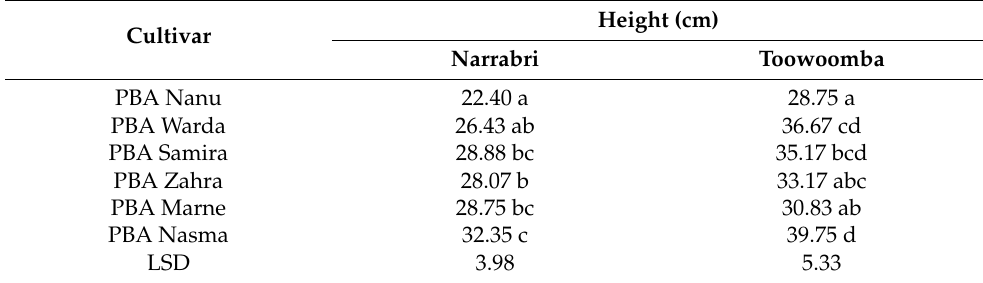
Table 4. Analysis of variance for 4 traits of faba bean cultivars tested at two locations.